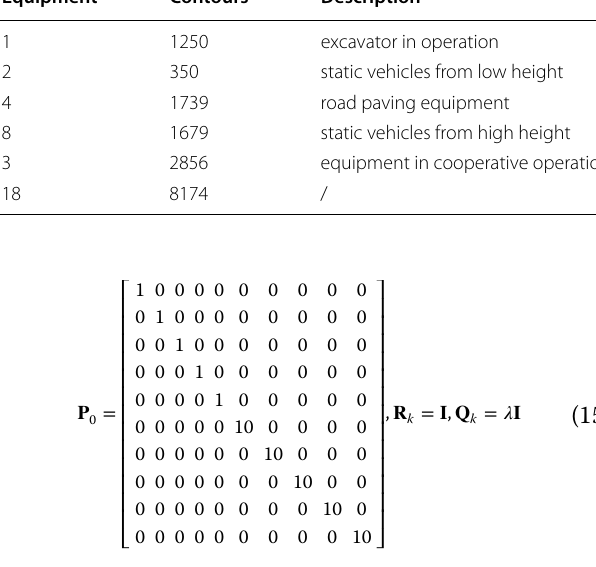
Table 1 Description of evaluation dataset for overhead-view construction equipment tracking